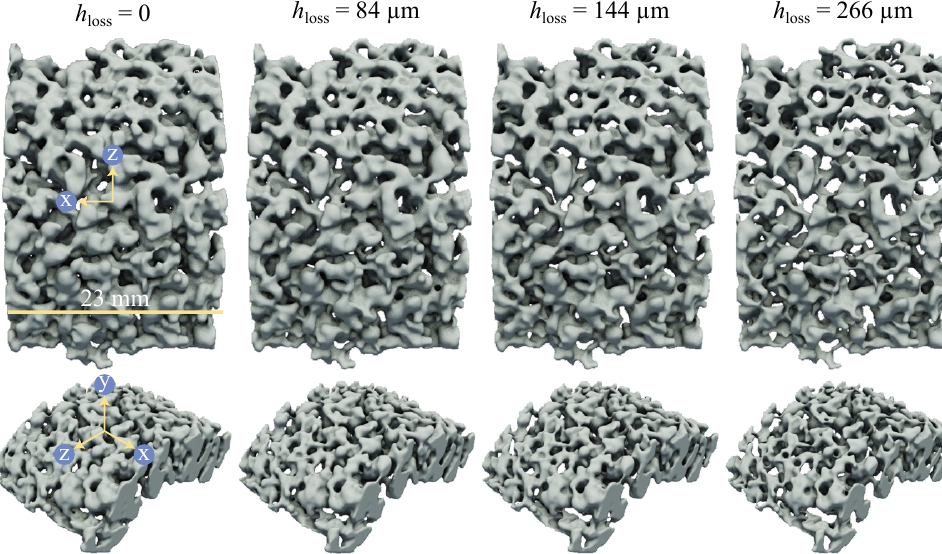
Figure 7. Porous matrix evolution during high-temperature oxidation-affected erosion. The cases are labeled by total average thickness of lost layer thickness h loss